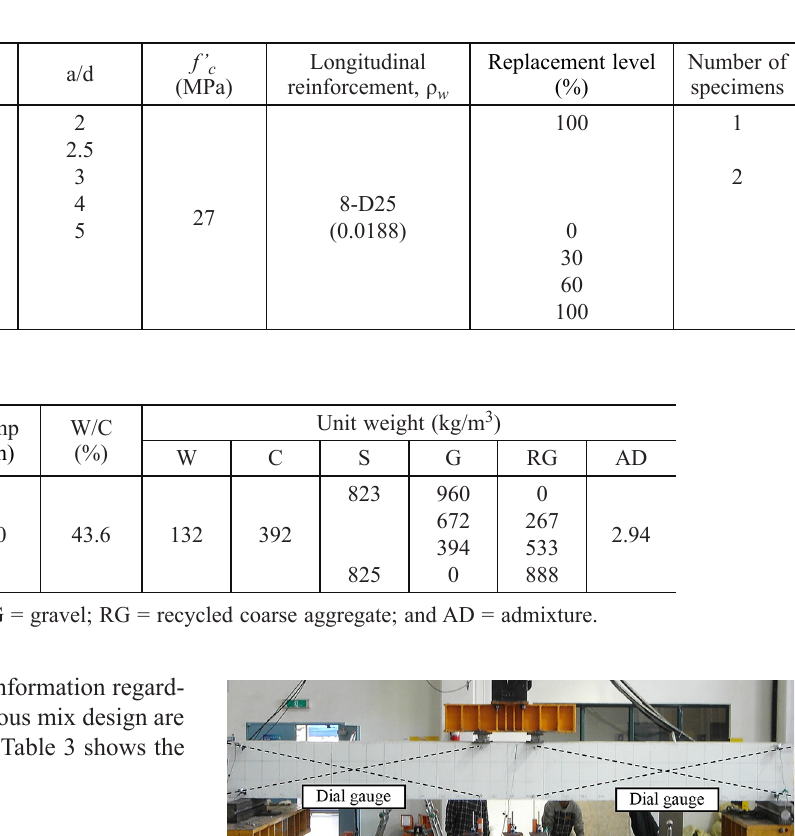
Table 4. Material properties of concrete